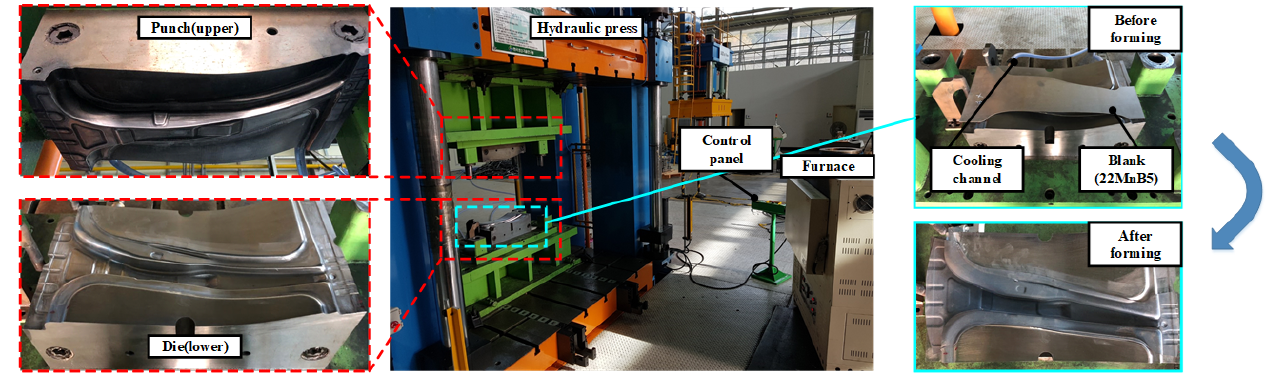
Figure 9. Experimental equipment for the hot stamping of the B-pillar.